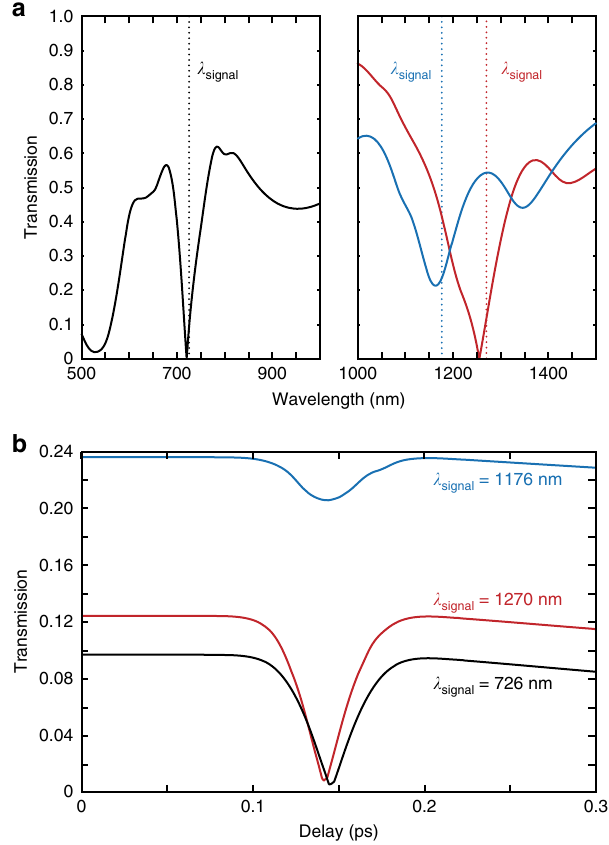
Fig. 3 Transmission resonances and the switching time. a Simulated transmission spectra for the extraordinary wave at an angle of incidence of 30° for three metamaterials: (black) nanostructure parameters as in Figs. 1 and 2 but using bulk Au permittivity 42 and two metamaterials optimised for higher transmission formed by nanorods with height, diameter, and period of (red) 680 nm, 25 nm, and 110 nm, respectively, and (blue) 550 nm, 27 nm, and 110 nm, respectively, for bulk Au permittivity. Dotted lines indicate the signal wavelength monitored in b